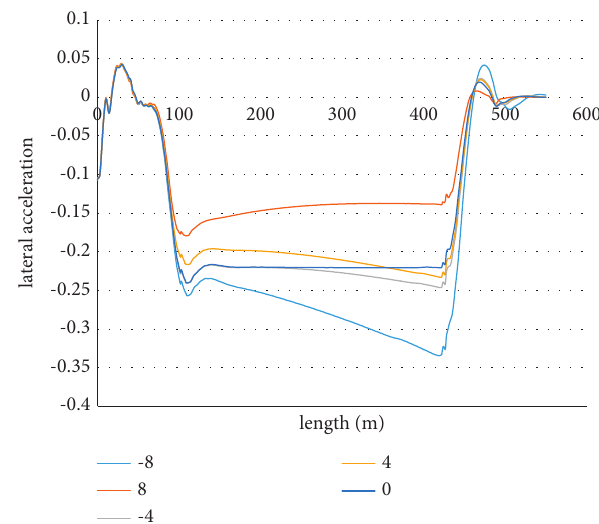
Figure 11: Comparison of lateral acceleration along the route on different slopes.